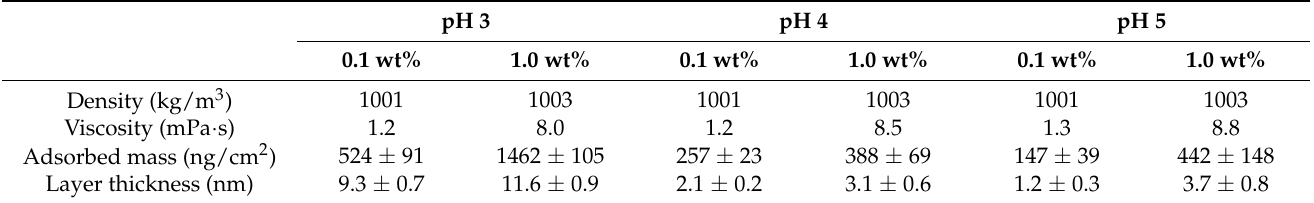
Table 1. Density and viscosity of pectin solutions (0.1 wt% or 1 wt% SPB at pH 3, pH 4, or pH 5) as well as estimated adsorbed mass and layer thickness obtained with the Voight